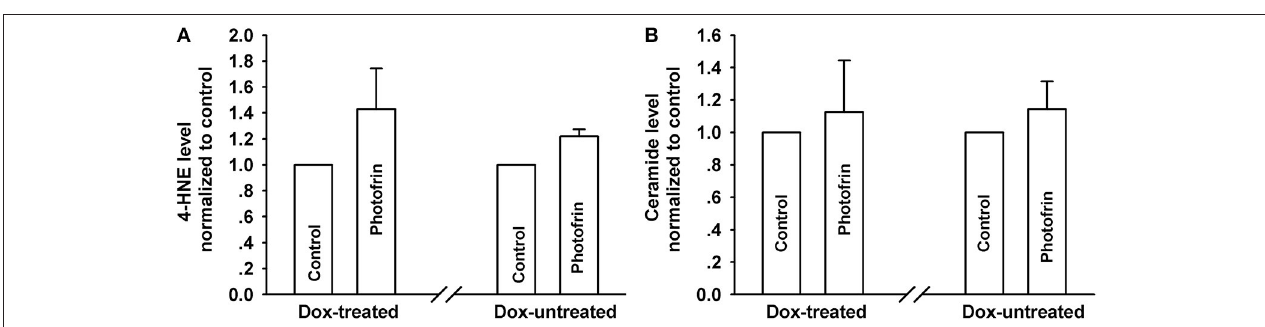
FIGURE 6 | Effects of Cx40-formed channels on 4-HNE and ceramide production after PDT. Cells were pretreated with or without Dox, then irradiated with or without Photofrin. The levels of 4-HNE and ceramide were detected using ELISA assay. (A) 4-HNE; (B) ceramide. For (A,B) , data points are mean ± SD from 3 experiments. t-test was used to assess statistically significant differences between